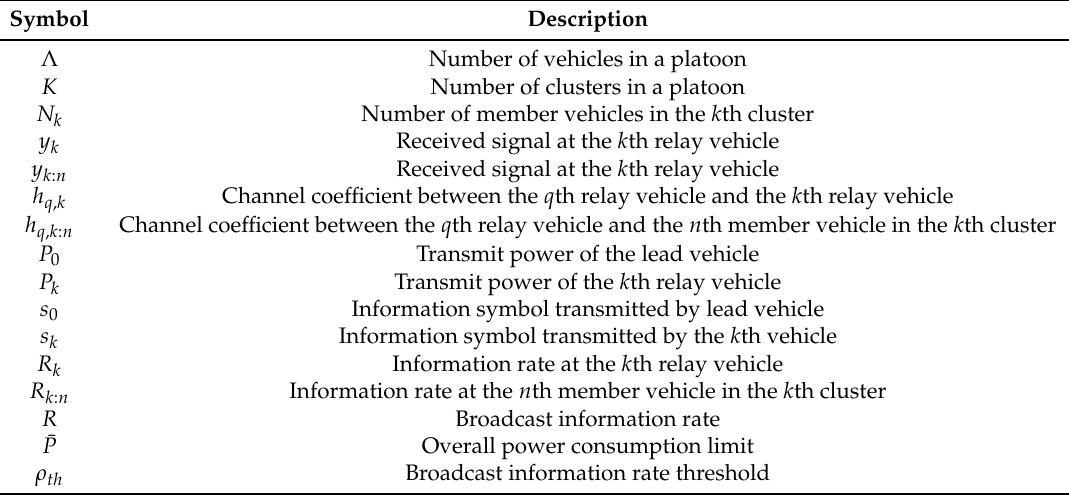
Table 1. List of key notations